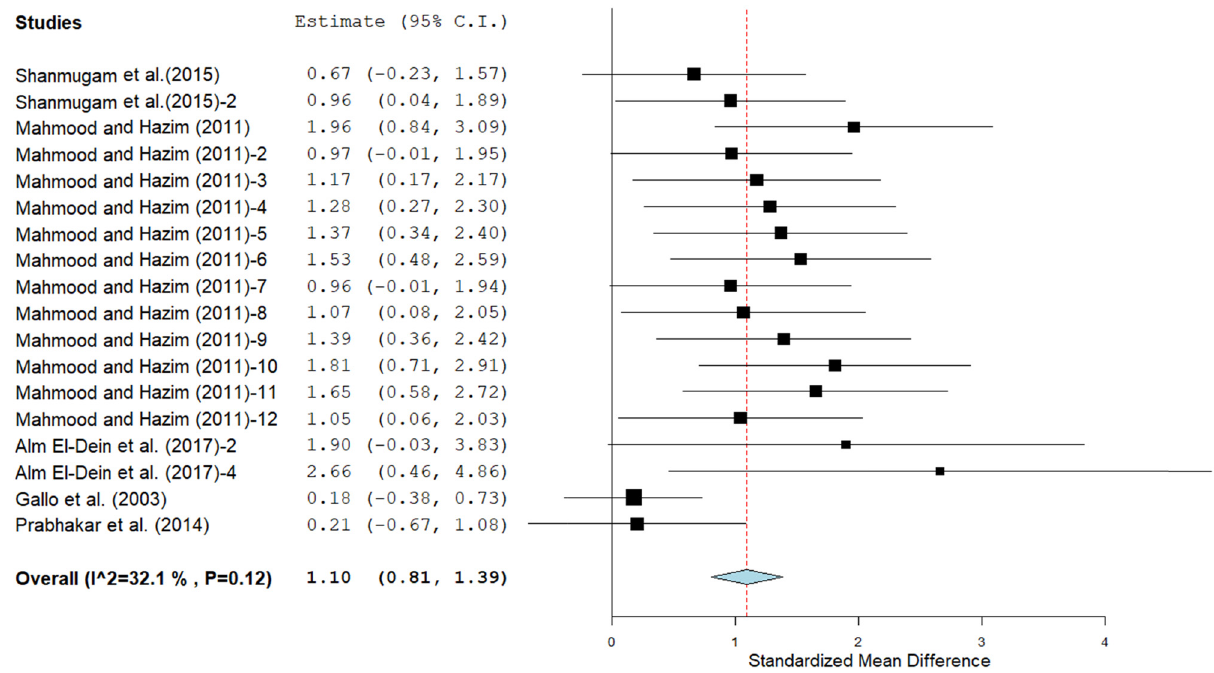
Figure 3: Impact of dietary zinc additive on sperm motility. The thick vertical line is the line of no e ff ect ( i.e. SMD = 0 ) . Points to the left of this thick vertical line connote a decrease in sperm motility, while points to the right show an increase in sperm motility. The dotted line shows the overall SMD. The result is considered signi fi cant the 95% CI of the overall SMD did not include